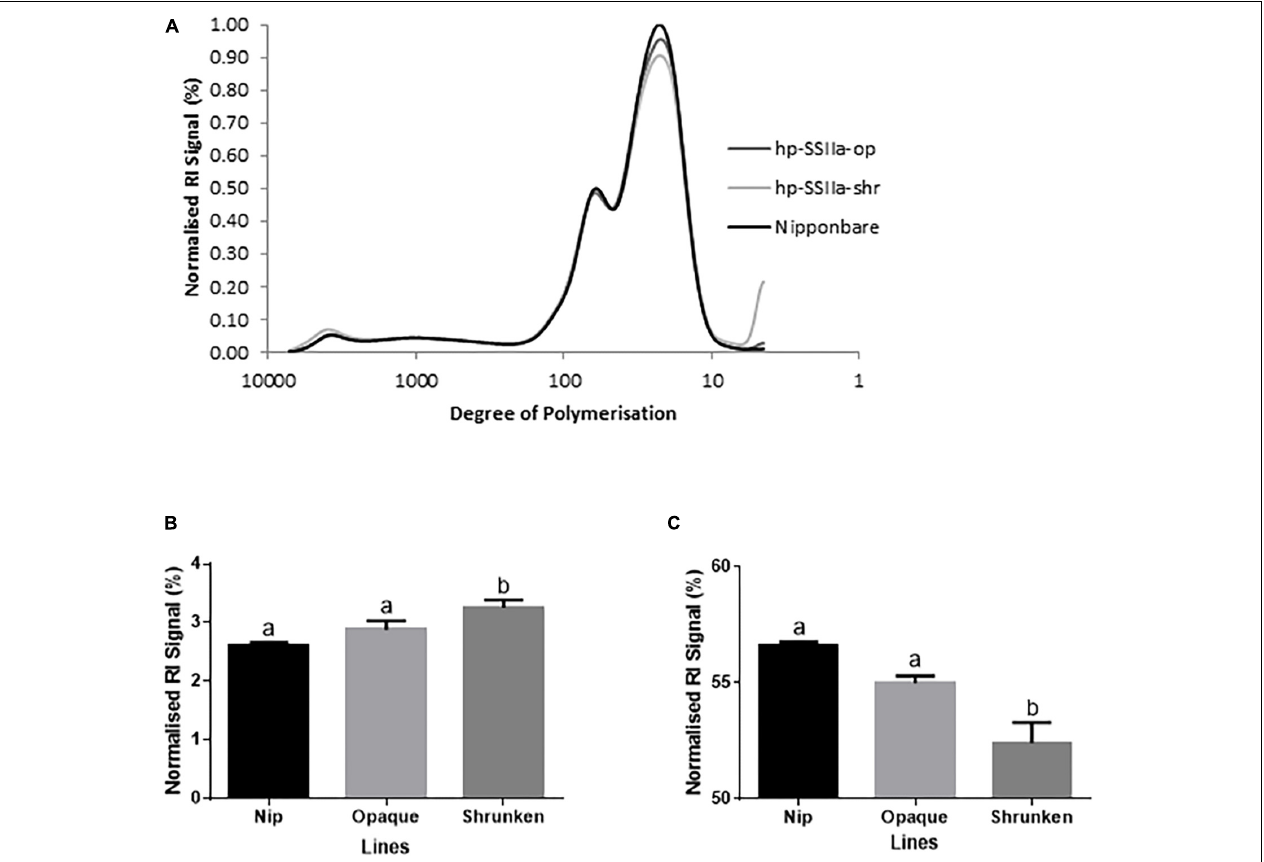
FIGURE 5 | Molecular size distribution profile of debranched starch in T1 generation by SEC (A) for representative lines of hp-SSIIa-op (SS3 and SS5) and hp-SSIIa-shr (SS17 and SS28) compared with Nipponbare control. (B) Short chain amylopectin (DP 6–12) were elevated ( P -value < 0.05) and (C) medium chain amylopectin (DP 13–36) were reduced ( P -value < 0.02) in the transgenic lines compared to Nipponbare control. The profiles show the distribution of normalized refractive index (RI) signals of debranched starches from each sample. Mean comparison with control using Bonferroni multiple comparison test revealed that only the shrunken lines have statistically significant result. Bars with different letters indicate significantly different mean. The identity of samples is indicated on the right side of the